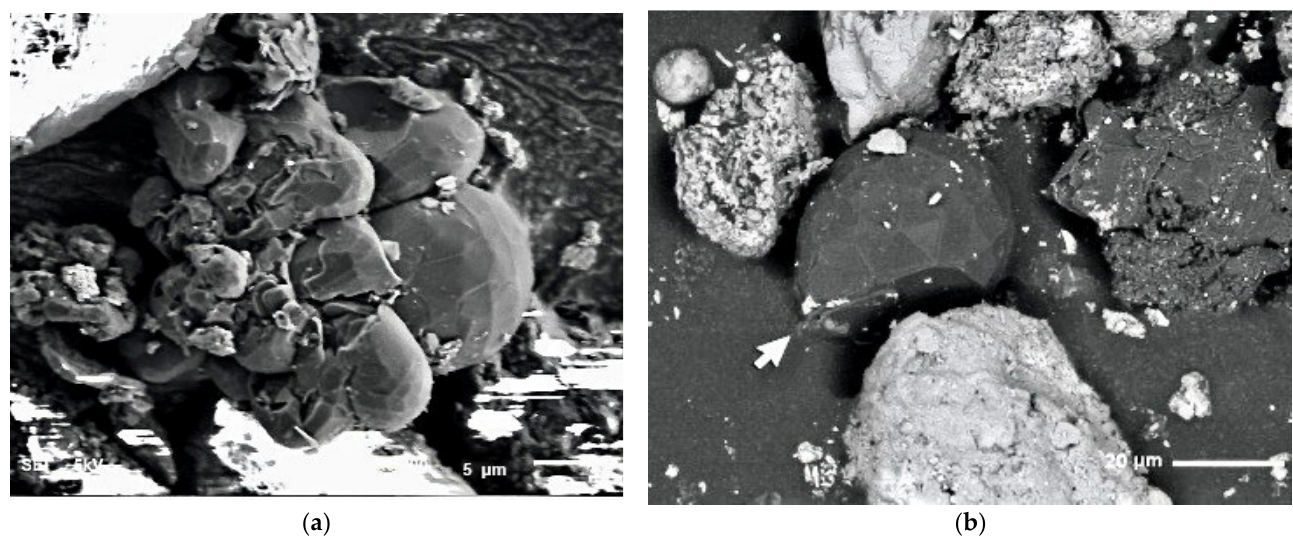
Figure 3. ( a ) Scanning electron microscopy image of a conglomerate of complex multifaceted polygonal ECM with 2000 magnification. ( b ) Scanning electron microscopy image of a complex multifaceted polygonal ECM with indented wall (2000 magnification).